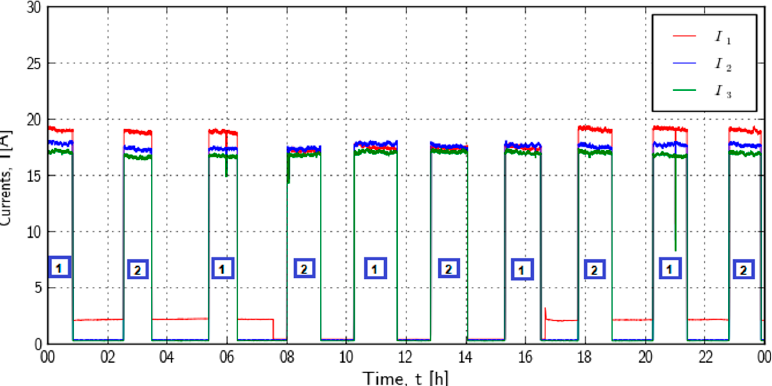
Figure 14. The diagrams of the PS load current changes recorded on 3 January 2022. 1: the PU1 is in operation, 2: the PU2 is in operation.